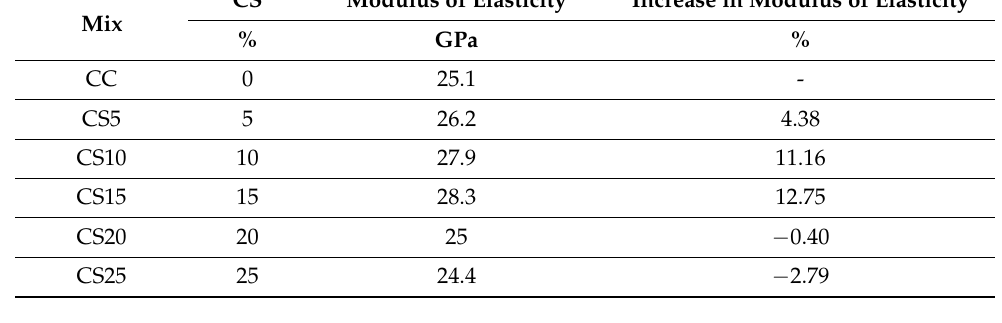
Table 6. Modulus of elasticity of CS concrete.